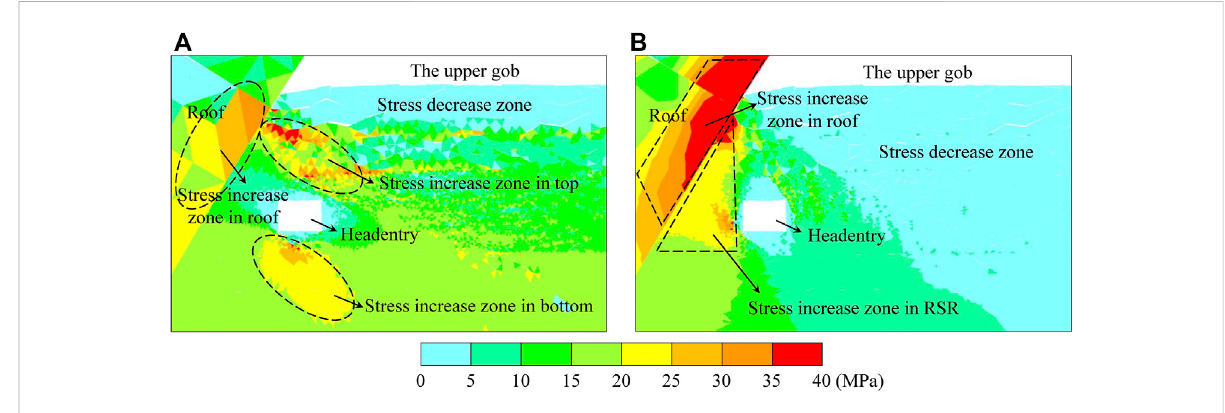
FIGURE 7 The stresses after the excavation of the upper mining section and the headentry: (A) horizontal stresses, and (B) vertical